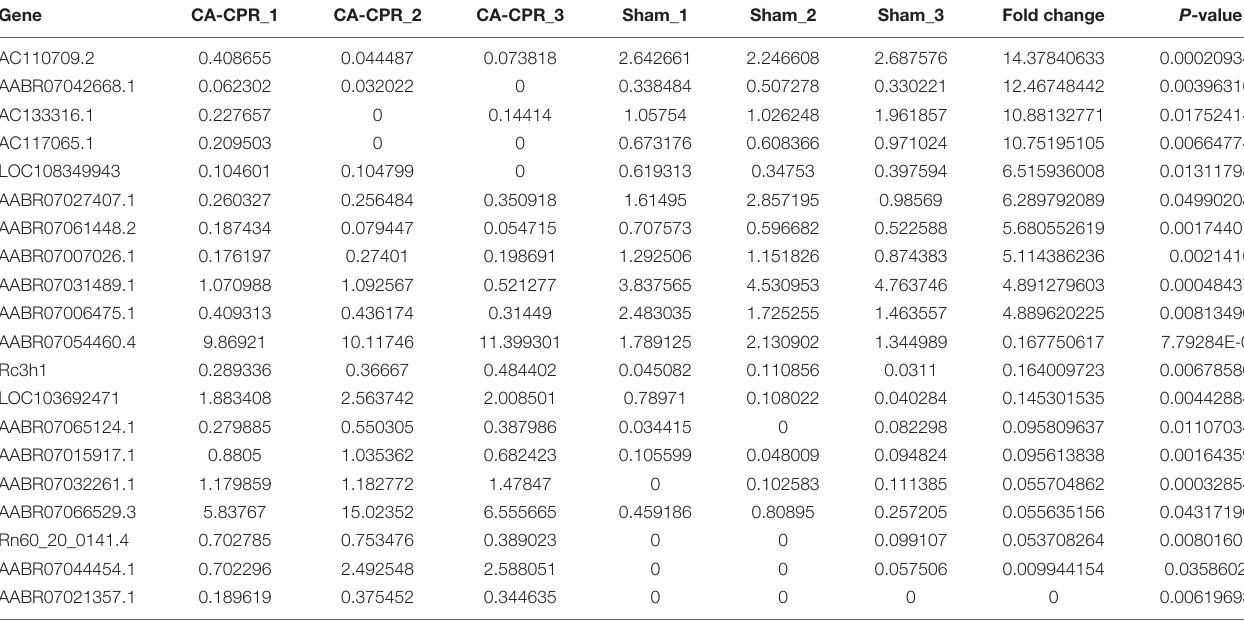
TABLE 2 | The top 20 differentially expressed lncRNAs detected by high-throughput sequencing analysis.